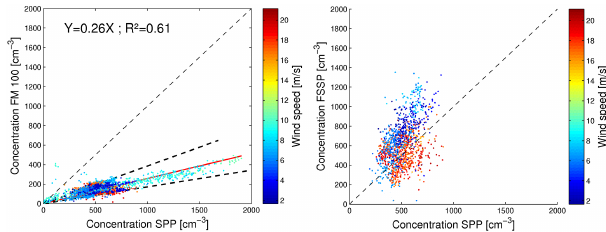
Figure 8. Scatter plots of the 10s averaged concentrations measured by the FM-100 (left) and the FSSP (right), in ambient conditions, with the wind tunnel SPP. The colors reveal the ambient wind speed. The bold dashed lines show the instrumental errors applied to the fit. The 99% confidence interval of the slope value was estimated to be [0.251,